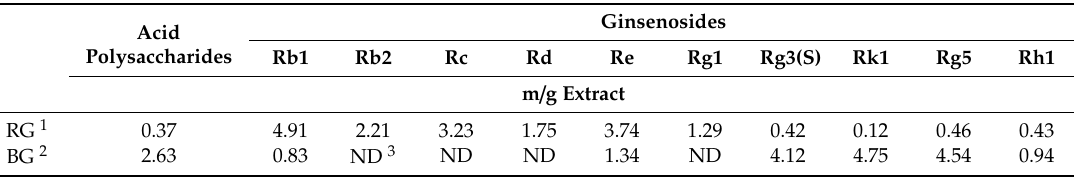
Table 1. The amounts of ginsenosides in BG and